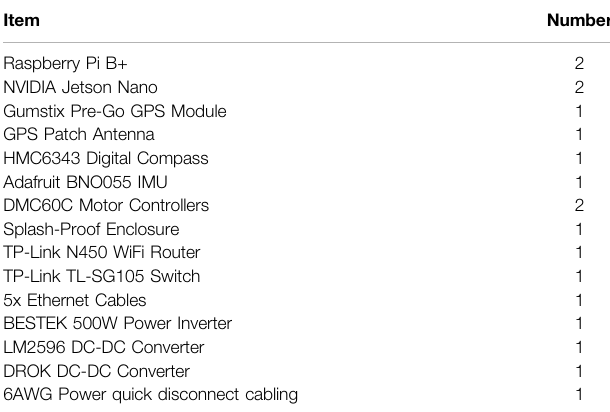
TABLE 1 | Itemized list of Autonomy Package